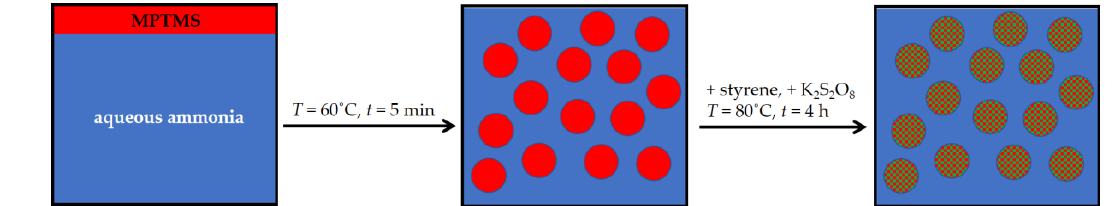
Figure 1. Schematic representation of the synthesis of hybrid particles consisting of poly(3- mercaptopropyl)siloxane and polystyrene.